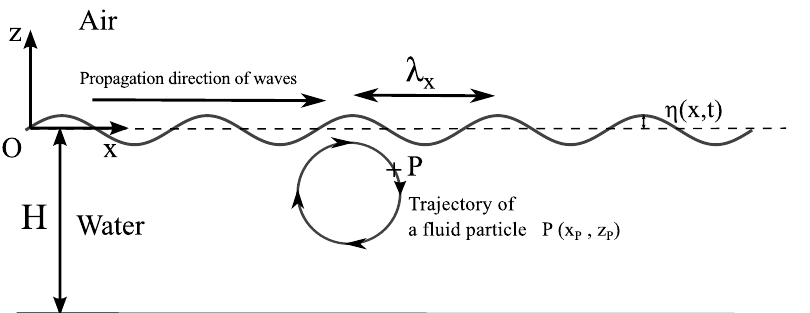
Figure 1. Schema. Propagation of a monochromatic water surface wave at the air/water interface for a two-dimensional wave propagating along k x . The wavelength is defined by λ x = 2 π / ( k x ) with k x = || k x || . The trajectory of fluid particles are nearly circular in a deep-water regime, i.e., tanh ( k x H ) ≈ 1 (in the schema k x H ≈ 8.3). The displayed trajectory is not to